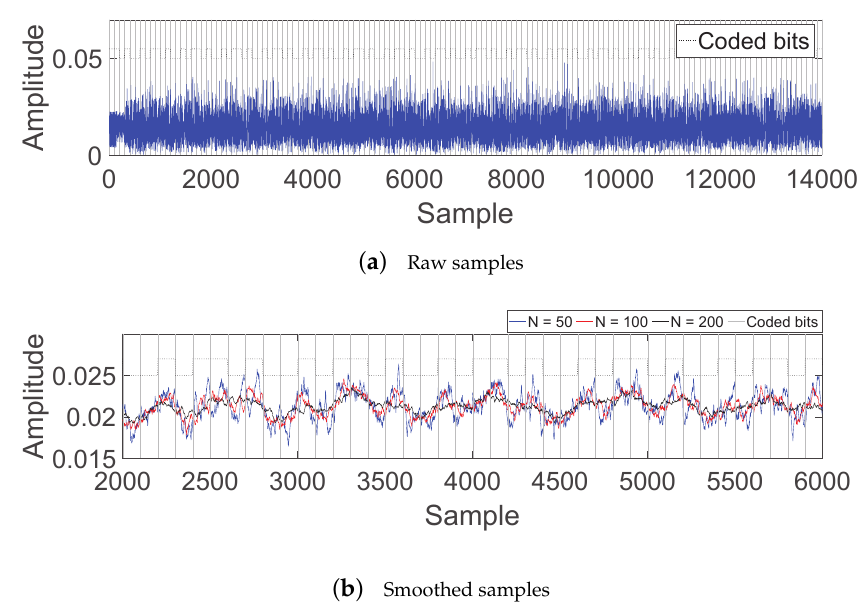
Figure 2. Samples of a received Wi-Fi frame with backscattering for variously sized average